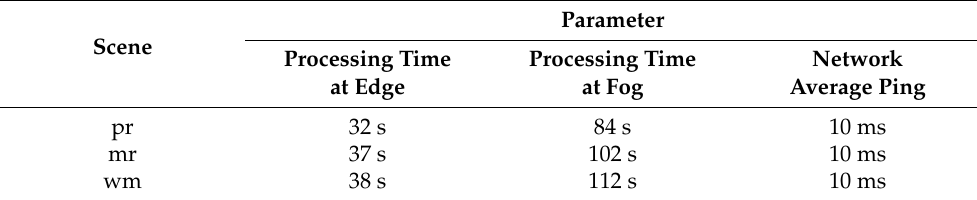
Table 5. Results from distributed execution